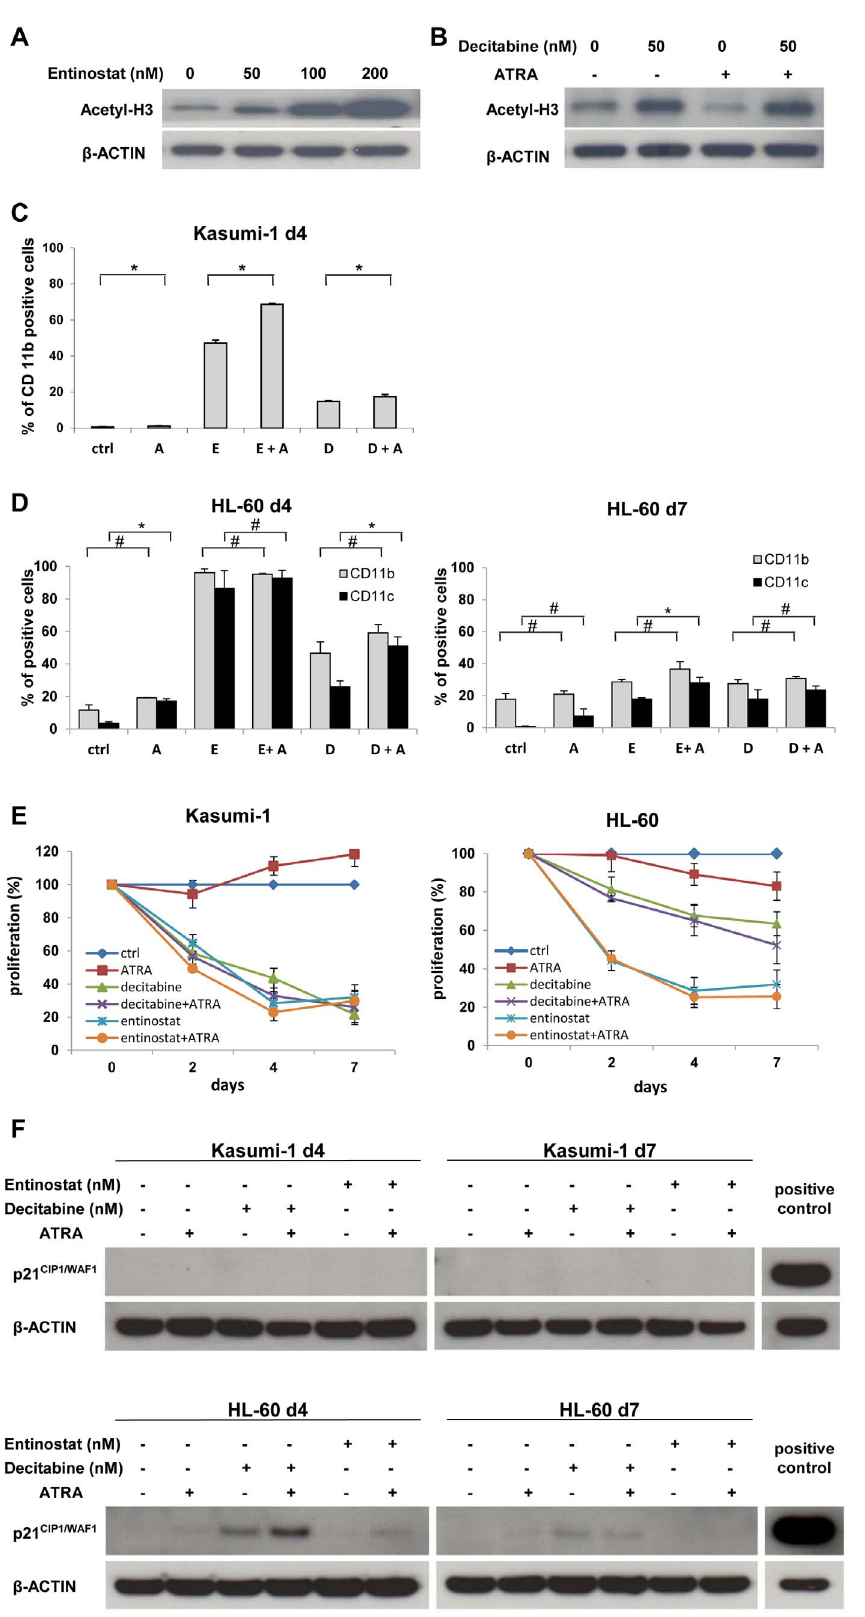
Figure 1. Priming effects of entinostat and decitabine for ATRA-induced differentiation in PML-RAR a -negative AML cell lines. Effects of entinostat ( A ) and decitabine ( B ) on histone acetylation in Kasumi-1 cells. Cells were treated with the indicated doses of entinostat or decitabine in